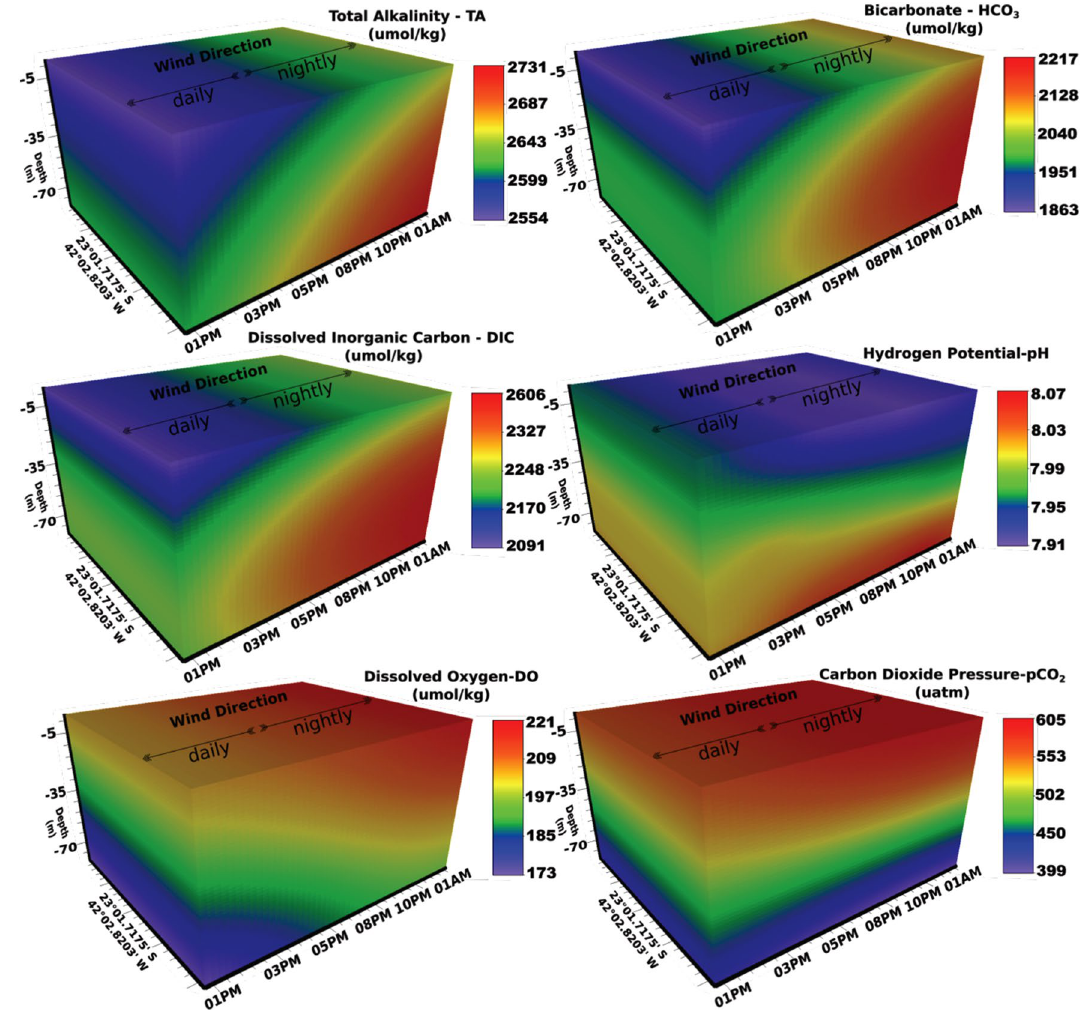
Figure 11. Temporal sampling. Total Alkalinity (µmol/kg), bicarbonate (µmol/kg), Dissolved Inorganic Carbon (µmol/kg), Potential Hydrogenionic (pH). Dissolved Oxygen (µmol/kg) and Carbon Dioxide Partial Pressure (atm). X-axis: hour–day. Y-axis: coordinates of stations. Z-axis: Depth-m. Data sampled from 1:00 p.m. to 1:00 a.m. on the 20th and 21st of January